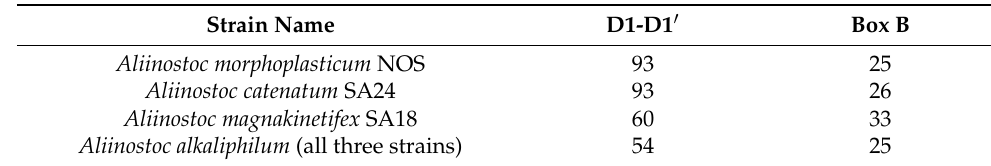
Table 1. Nucleotide sequence length of D1-D1 (cid:48) and box B regions of 16S-23S ITS of known Aliinostoc